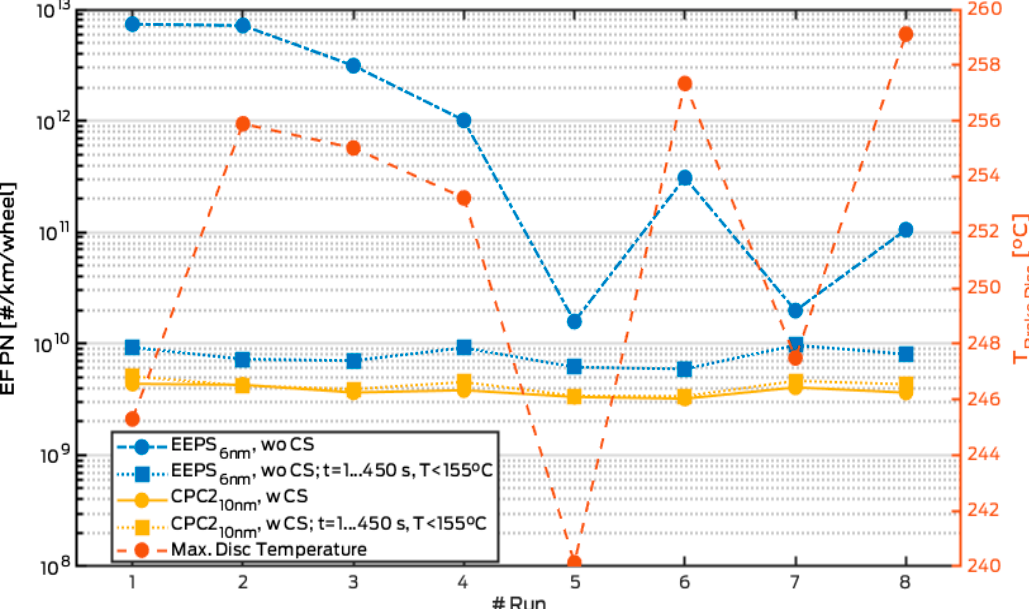
Figure 5. PN EFs estimated for eight runs of the LACT-20 on the chassis dynamometer based on the EEPS (w/o CS) and CPC2 10nm (CS). The EEPS EFs during runs one to four is the lower EF limit since the particle concentration exceeded the measurement limit. As reference, EF from EEPS and CPC2 are shown during first 450 s where the temperatures are < 155°C.